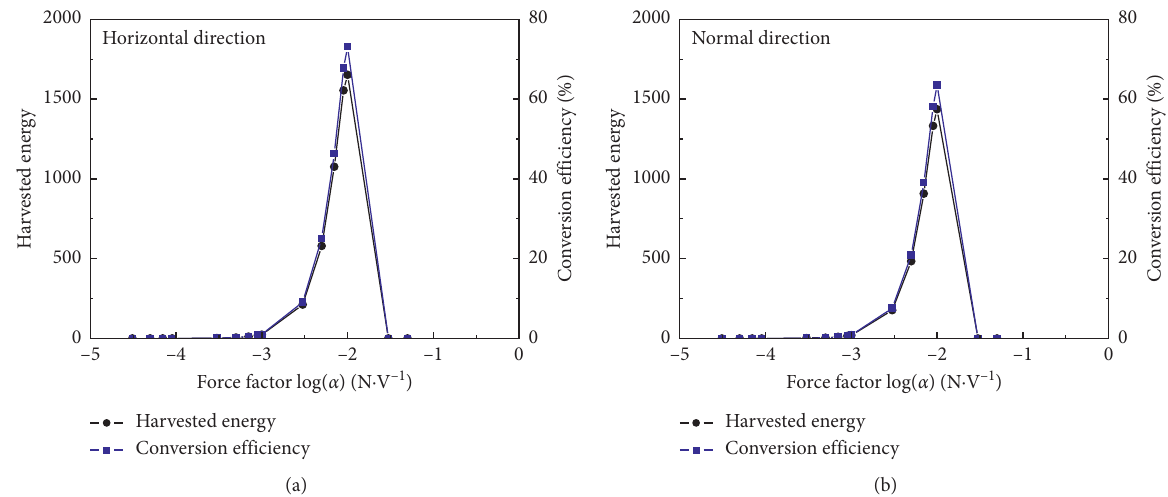
Figure 31: Ignoring separation, the harvested energy and conversion efficiency of the friction system in the horizontal direction (a) and normal direction (b) with different force factors of piezoelectric elements.